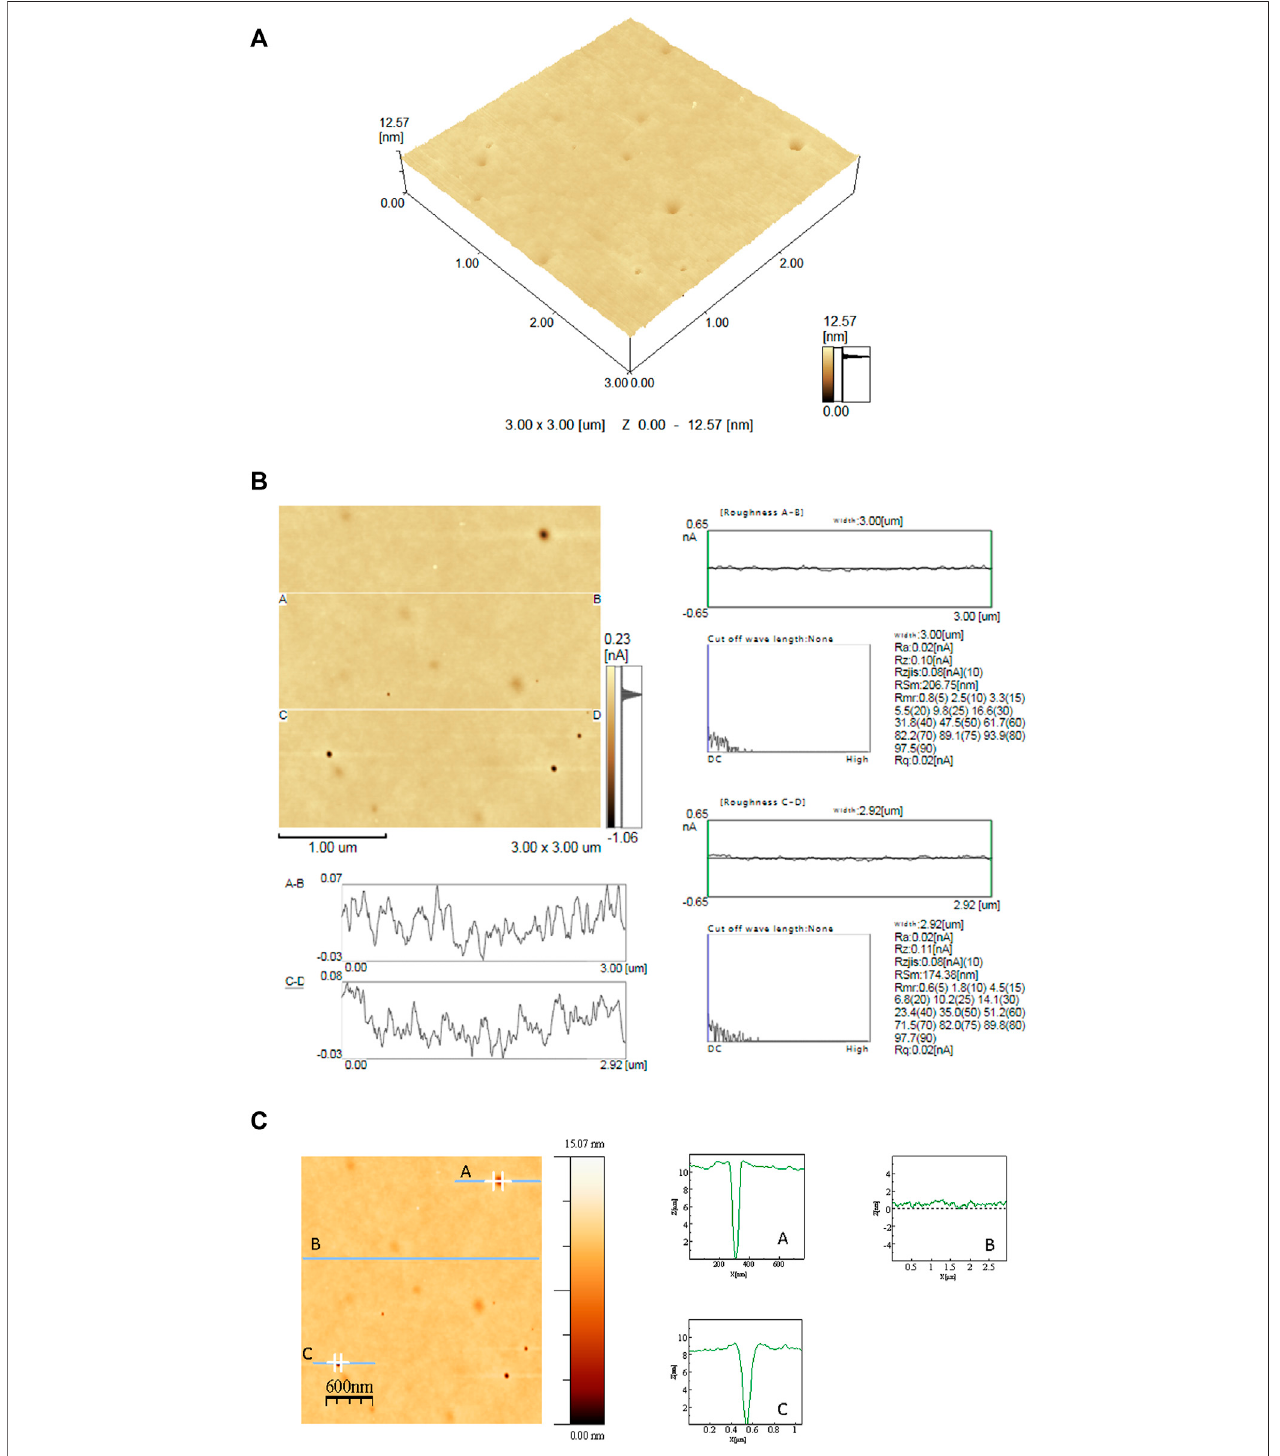
FIGURE 5 | 3D (A) and 2D (B) AFM topographical images, obtained in the contact mode, of the 0.03% Er 3+ -doped SiO 2 -Ta 2 O 5 multilayered fi lm prepared by the sol-gel route and deposited on a SiO 2 /Si substrate. (C) 2D AFM topographical image obtained in the contact mode of drawing pro fi le lines the 0.03% Er 3+ -doped SiO 2 - Ta 2 O 5 multilayered fi lm prepared by the sol-gel route, deposited on a SiO 2 /Si substrate.